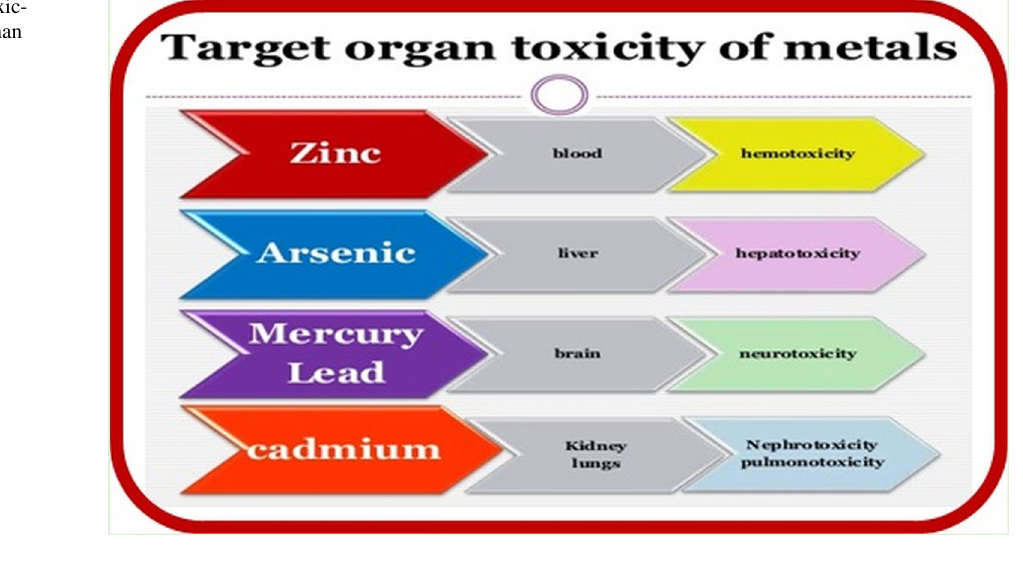
Fig. 1 The target organ toxic-